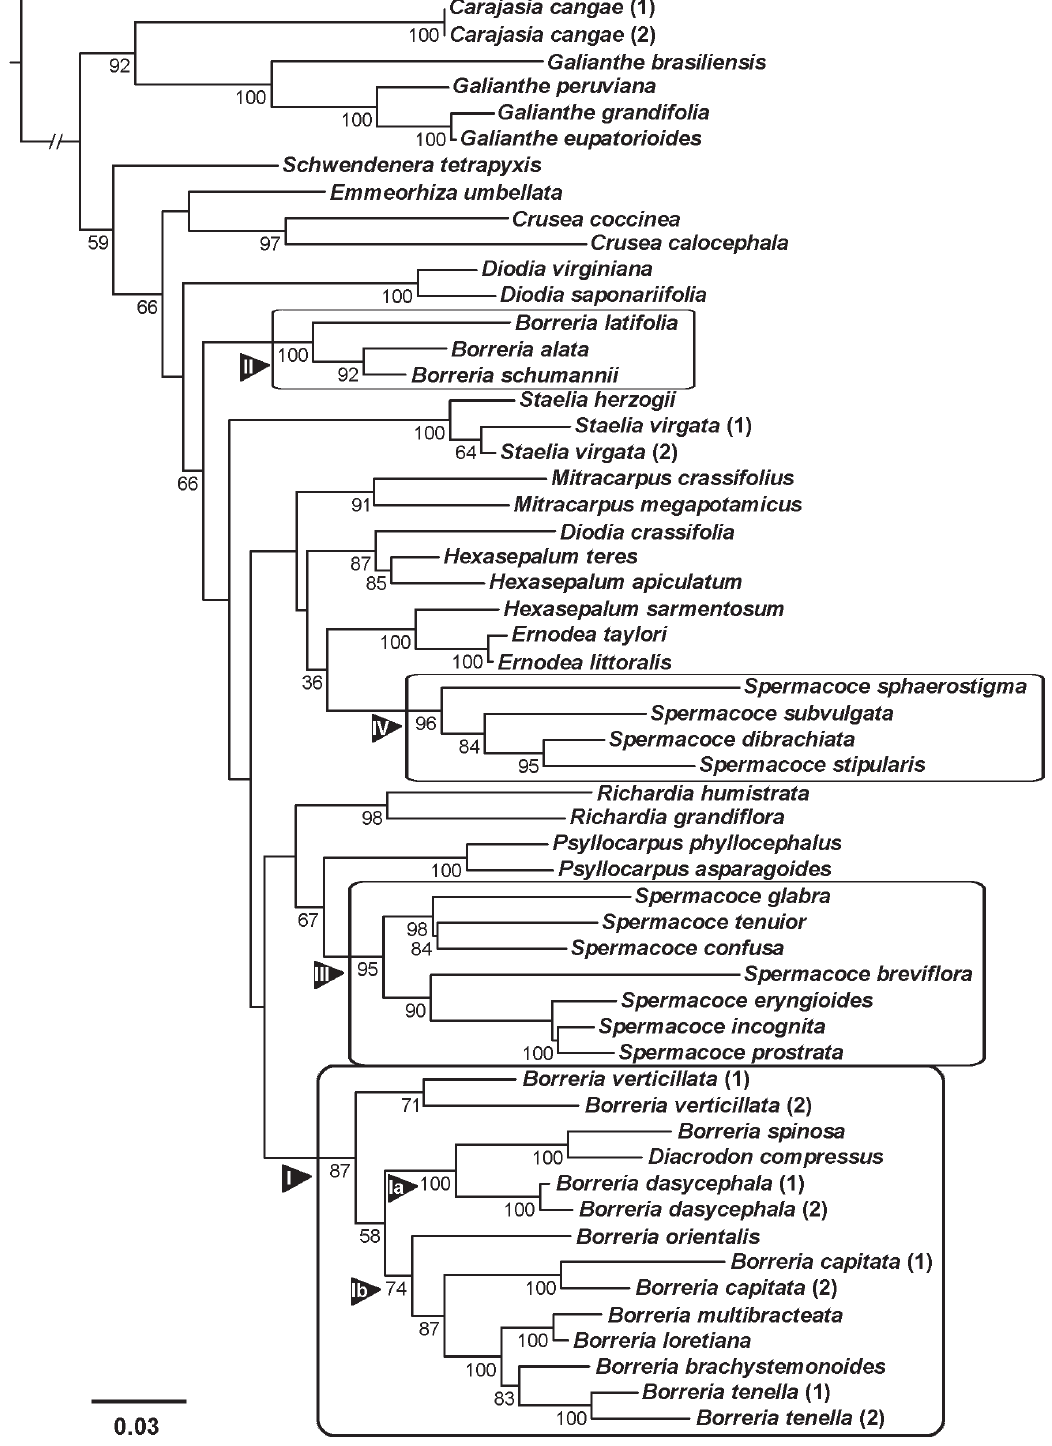
Figure 1 - ML tree showing phylogenetic position of Diacrodon in Spermacoce clade based on nuclear (ITS, ETS) data. Values at the nodes represent bootstrap support